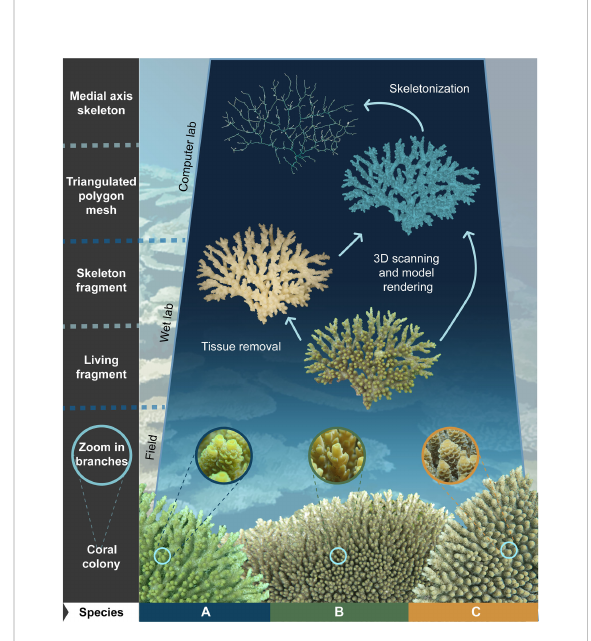
FIGURE 1 Schematic representation of three-dimensional (3D) model rendering and skeletonization work fl ow from complex-shaped organisms. Coral morphology can be analysed by 3D scanning either live (Reichert et al., 2016) or voucher skeleton specimens (as in this study; see Wet lab section). Here, three species of tabular Acropora corals (i.e., A, B, and C) identi fi ed using diagnostic characters in the fi eld (see Coral colonies and Zoom to the branches) and later con fi rmed using different lines of evidence (Ram ı ́ rez-Portilla et al., 2022) were used as a case study (coral photos by A.H. Baird). Downstream processing rendered 3D models as triangulated polygon meshes or medial axis skeletons (see Computer lab section) from which variable types such as curvature, branching, and complexity were estimated (see Table 1, Figure 2, and Supplementary Figure